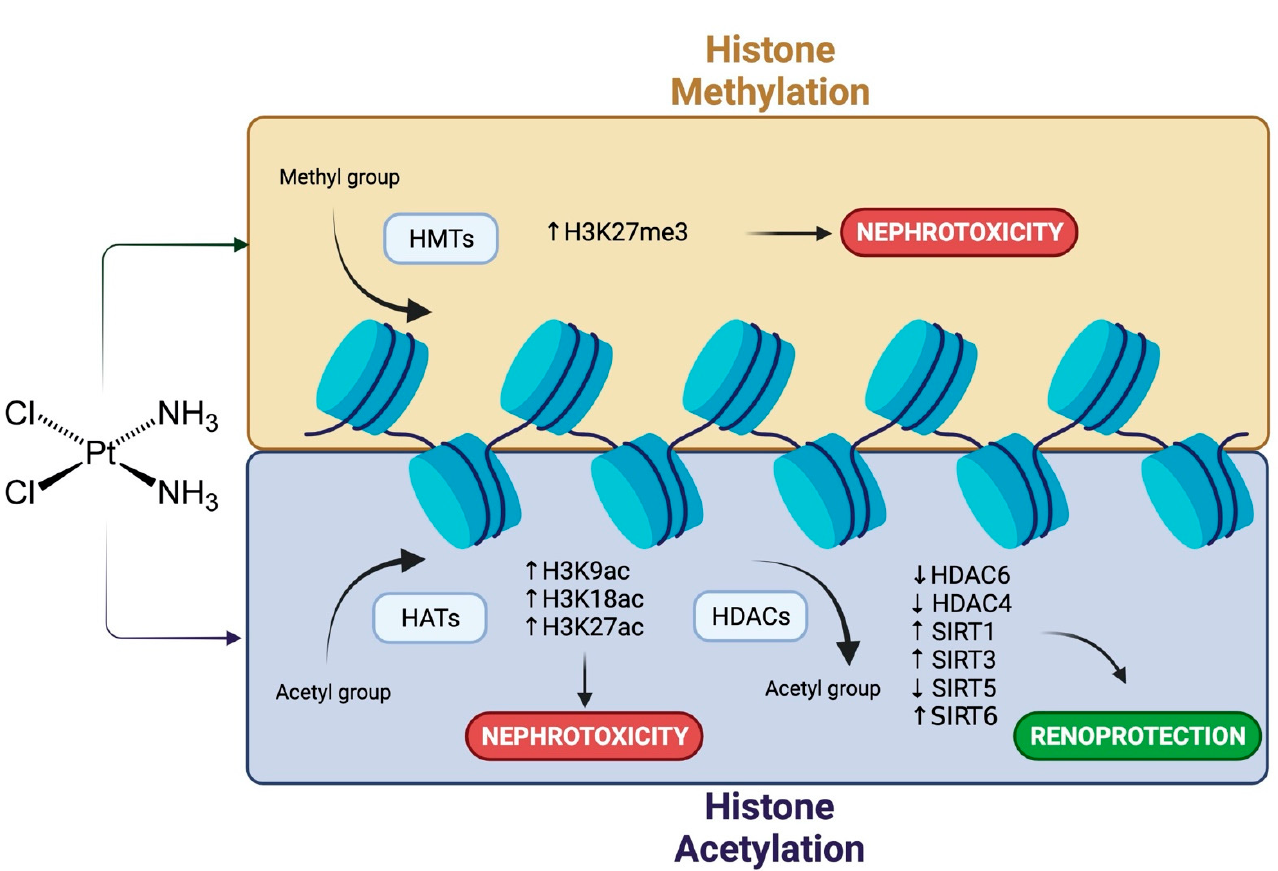
Figure 2. Proposed role of histone modifications in the regulation involved in cisplatin-induced nephrotoxicity. Created with BioRender.com accessed on 21 May .